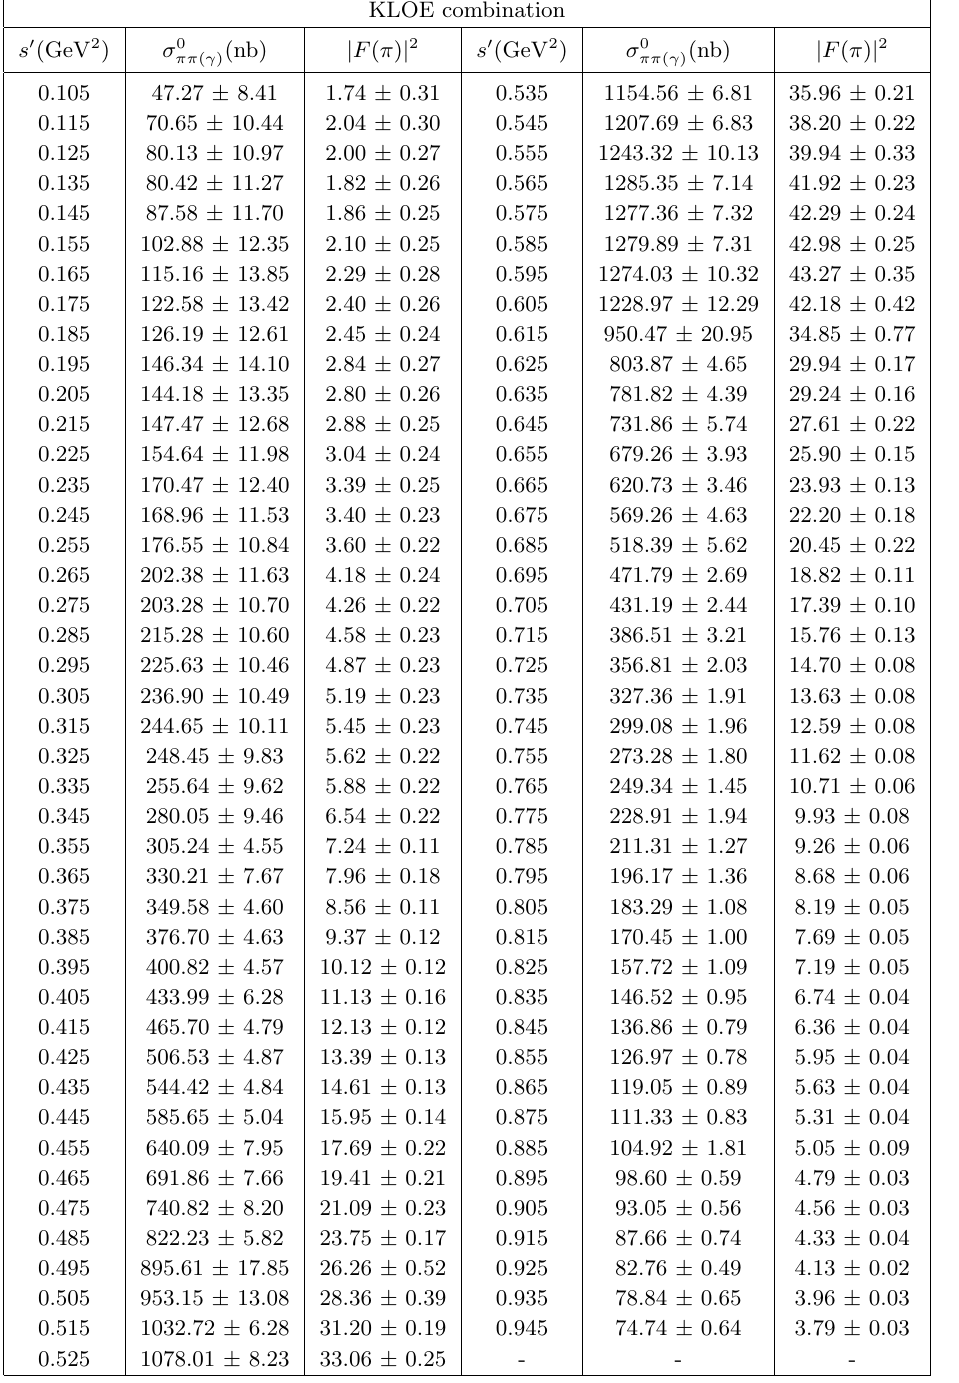
Table 1. The combined KLOE measurement of the (cid:25) + (cid:25) (cid:0) (cid:13) ( (cid:13) ) bare cross section and pion form factor in 0 : 01 GeV 2 intervals from 0 : 10 < s 0 < 0 : 95 GeV 2 . Here, s 0 denotes the bin centre. For both (cid:27) 0 and j F ( (cid:25) ) j 2 , the error shown is the total (statistical and systematic) uncertainty. The (cid:25)(cid:25) ( (cid:13) ) errors have been in(cid:13)ated according to the local (cid:31) 2 = d : o : f : in each energy bin, where in(cid:13)ation is min only applied if (cid:31) 2 = d : o : f : > min